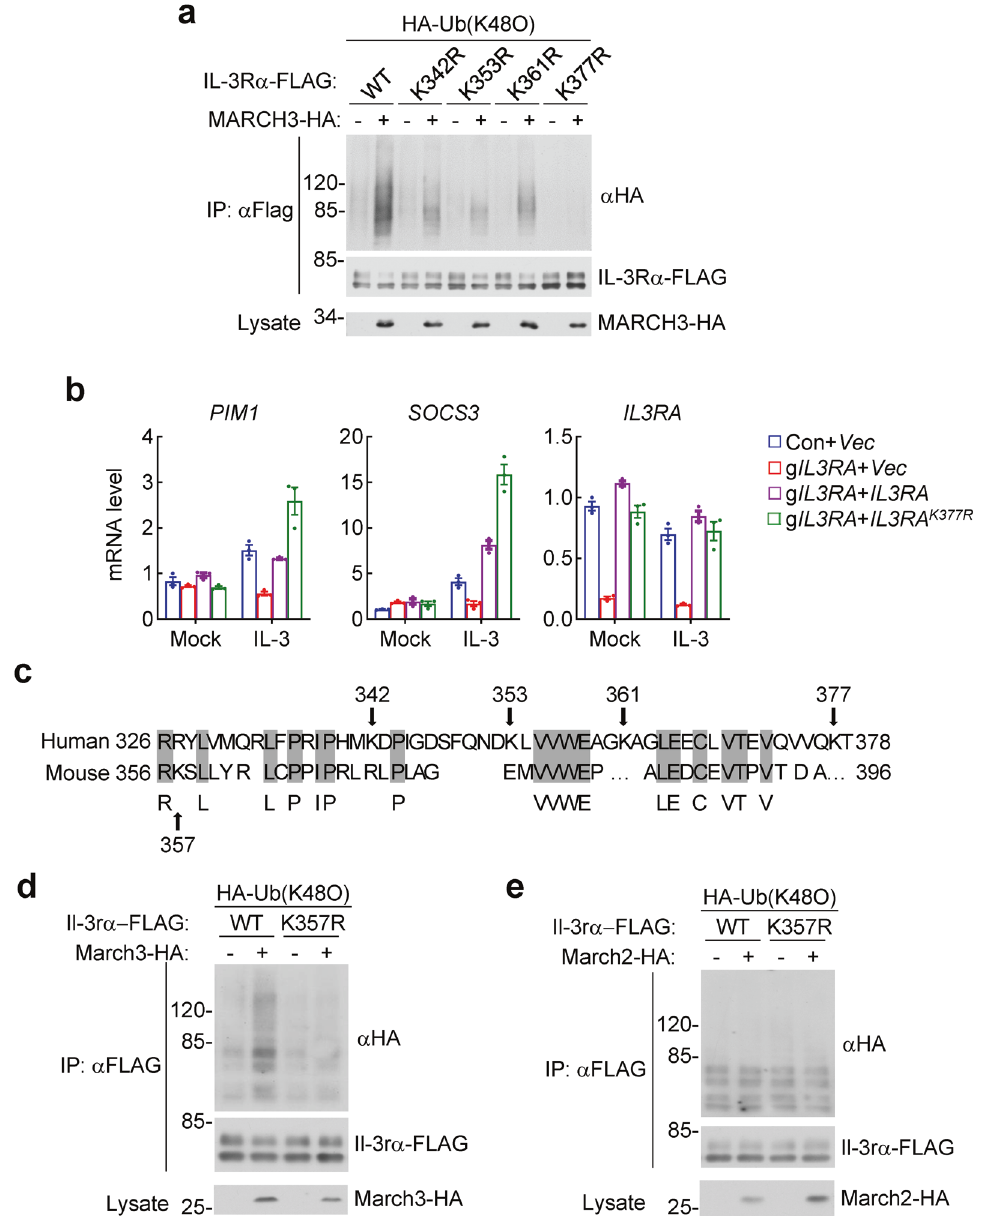
Fig. 4 MARCH3 mediates K48-linked polyubiquitination of IL-3R α at K377. a MARCH3 catalyzes K48-linked polyubiquitination of IL-3R α at K377. Human embryonic kidney 293 cells (2 × 10 6 ) were transfected with the indicated plasmids for 20 h. Cell lysates were then immunoprecipitated with anti-FLAG. The immunoprecipitates were denatured and then re-immunoprecipitated with anti-FLAG. The fi nal immunoprecipitates and cell lysates were analyzed by immunoblots with anti-HA or anti-FLAG. HA-Ub (K48O), HA-tagged ubiquitin with all lysine residues mutated to arginine except K48. b IL-3R α K377R has increased ability than IL-3R α in mediating IL-3-triggered signaling. IL-3R α - de fi cient human erythroleukemia TF-1 cells were reconstituted with wild-type IL-3R α and IL-3R α K377R by lentiviral-mediated gene transfer. The reconstituted TF-1 cells (5 × 10 5 ) were starved overnight and stimulated with IL-3 (10 ng/mL) for 1 h before qPCR analysis for mRNA levels of the indicated genes. Data shown are means ± SEM from one representative experiment performed in triplicate. c Sequence alignment of the cytoplasmic domains of human and murine IL-3R α . The sequences are corresponding to aa326-378 of human IL-3R α and aa356-396 of murine Il-3r α . d March3 but not March2 catalyzes K48-linked polyubiquitination of Il-3r α at K357. HEK293 cells (2 × 10 6 ) were transfected with the indicated plasmids for 20 h. Cell lysates were then immunoprecipitated with anti-FLAG. The immunoprecipitates were denatured and then re- immunoprecipitated with anti-FLAG. The fi nal immunoprecipitates and cell lysates were analyzed by immunoblots with anti-FLAG or anti-HA. All the experiments were repeated for at least two times with similar